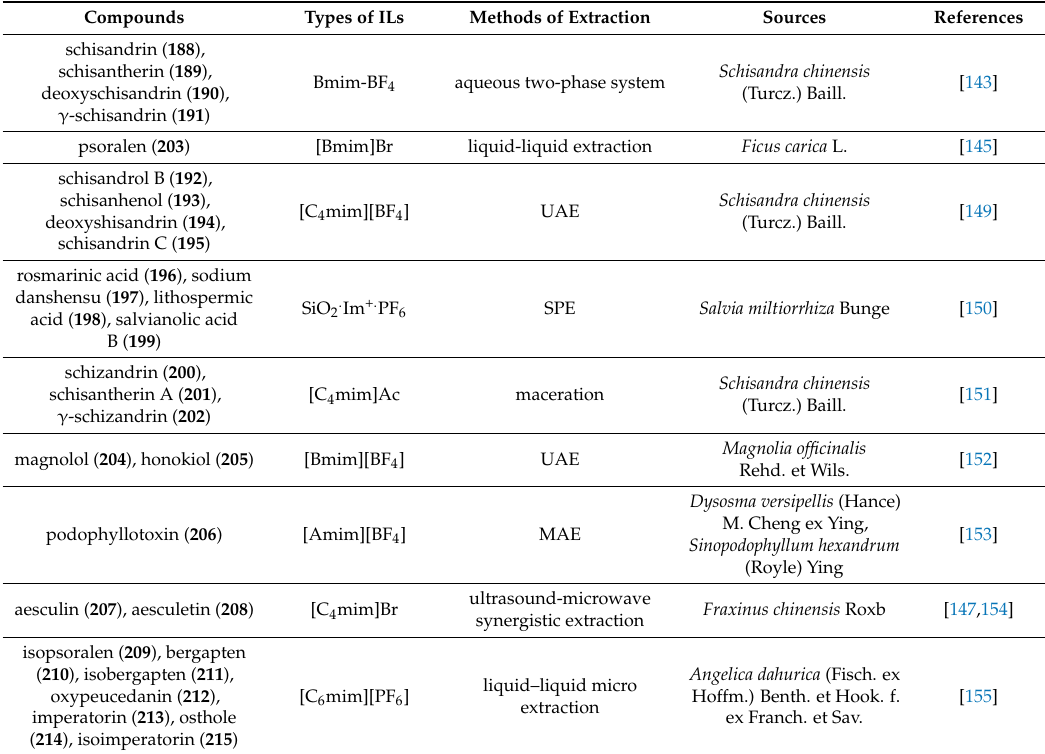
Table 7. The phenylpropanoids extracted from natural sources using ILs or IL solutions by different extraction